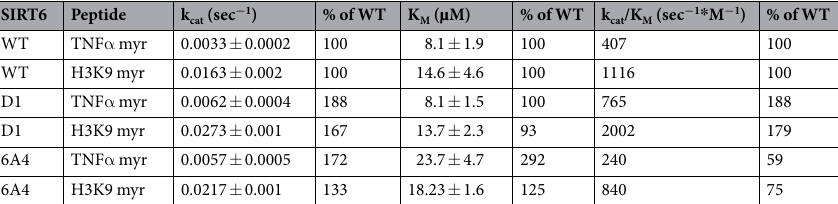
Table 1. Catalytic parameters of SIRT6 variants with TNF- α K20myr and H3K9myr